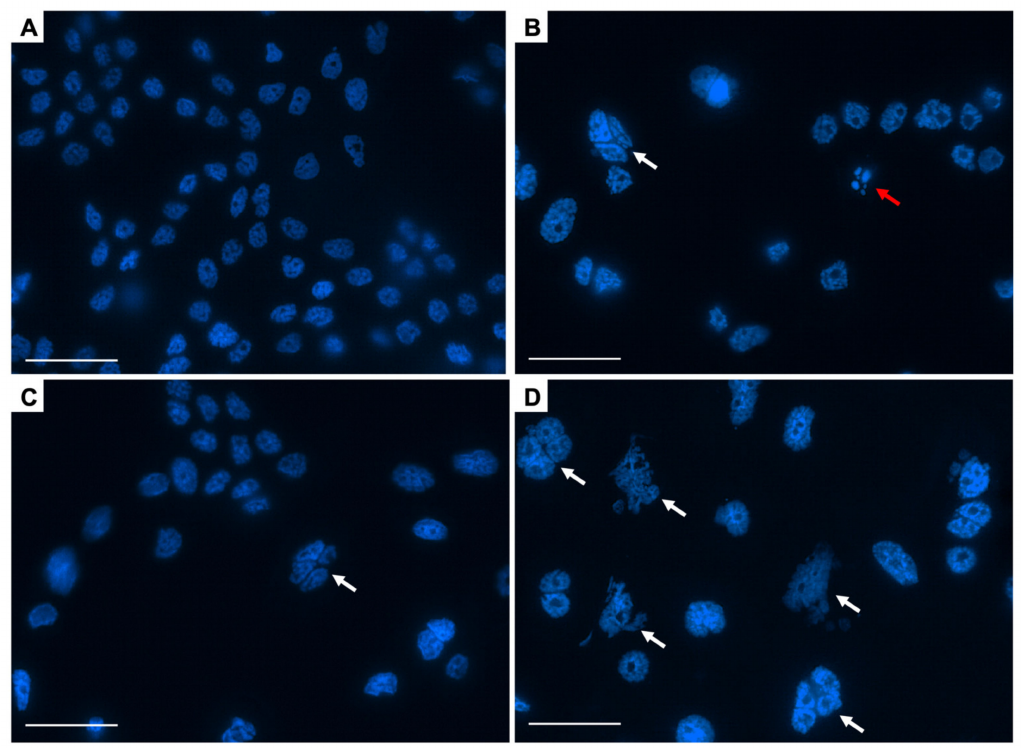
Figure 3. Representative images of DAPI-stained nuclei. A549 cells were treated with X-rays (4 Gy) and/or LY2874455 (100 nM) from 1 h pre-irradiation until staining with DAPI 72 h later. ( A ) No treatment. ( B ) X-rays. ( C ) LY2874455. ( D ) X-rays and LY2874455. Images were obtained using a × 60 lens. White arrows indicate mitotic catastrophe. A red arrow indicates apoptosis. Scale bars, 50 µ m.